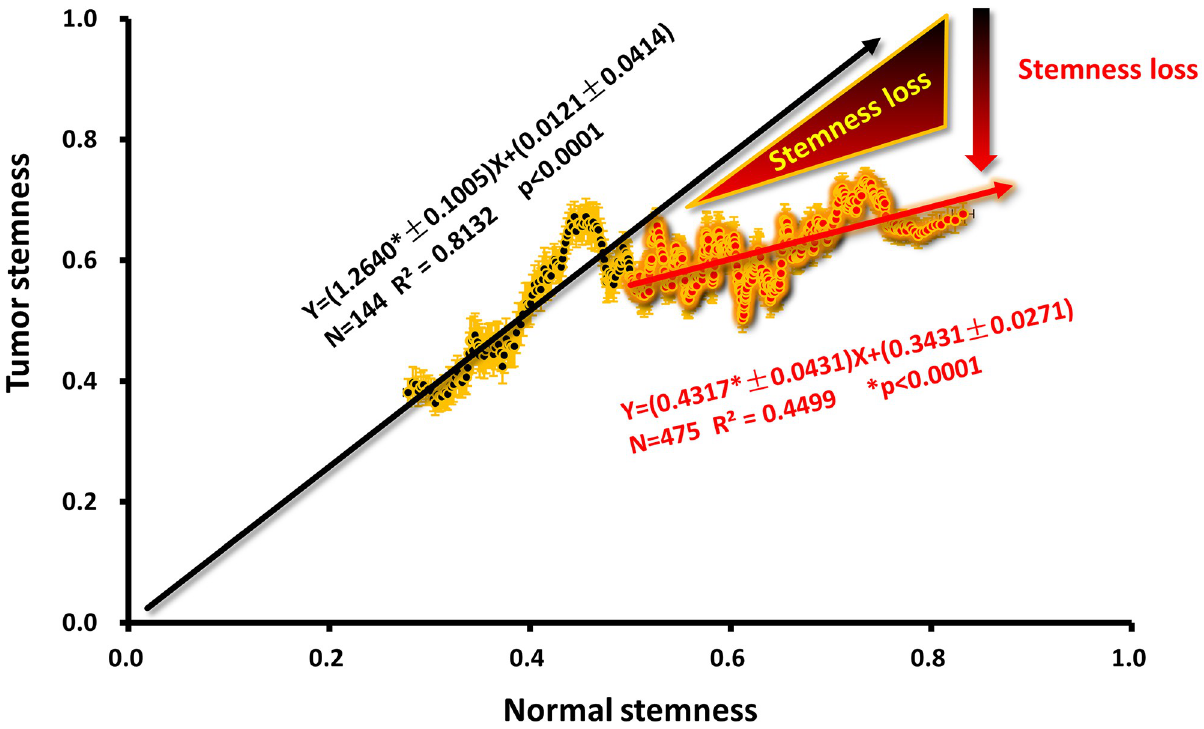
Fig 5. Tumor stemness as a function of tumor stemness. The linear regression results of the denoised clinical data (Tumor stemness and normal stemness) in the normal stemness interval (0, 0.5) are shown in black, and the linear regression results in the normal stemness interval (0.5, 1) are shown in red. The error in orange shows the calculated SEM while denoising. The red triangle and the black-to-red gradient arrow (labeled stemness loss) represent the difference between the measured value of Tumor stemness in the interval (0.5, 1) and the extrapolated value of the trend in the interval (0, 0.5). The error of the slope and intercept is directly expressed in the regression equation ( ± behind the value represents error; N is the total number of data; R 2 is the square of the correlation coefficient; p is the p -value for which the slope is not zero; � means significant).